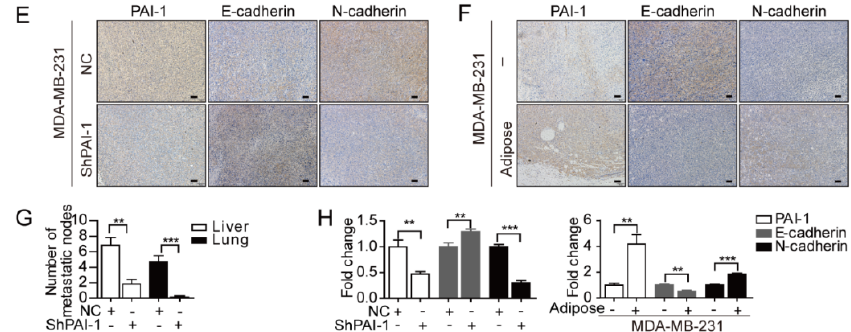
Figure 4. Depletion of PAI-1 blocks EMT and metastasis of breast cancer cells. ( A ) Western blot analysis